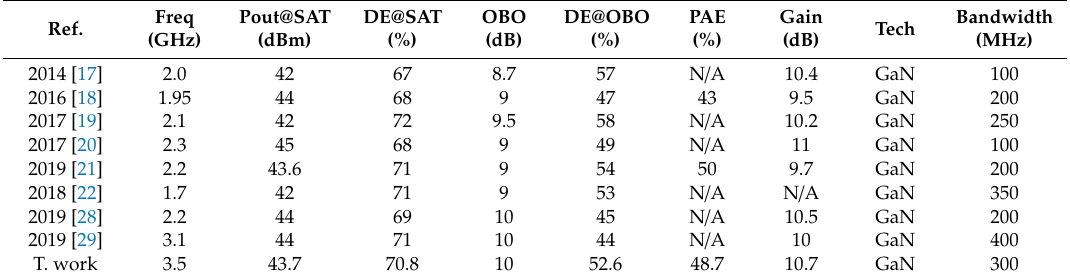
Table 1. Performances Compared with Recent Symmetrical DPAs.